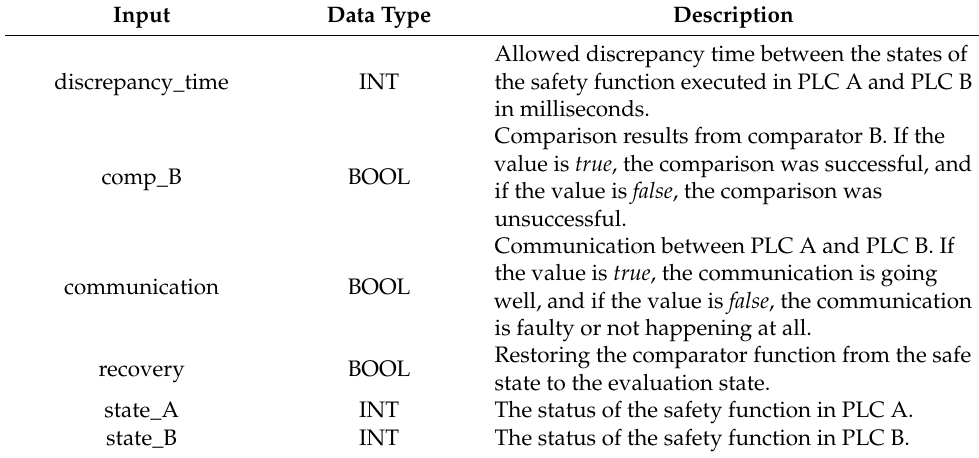
Table 3. Comparator input